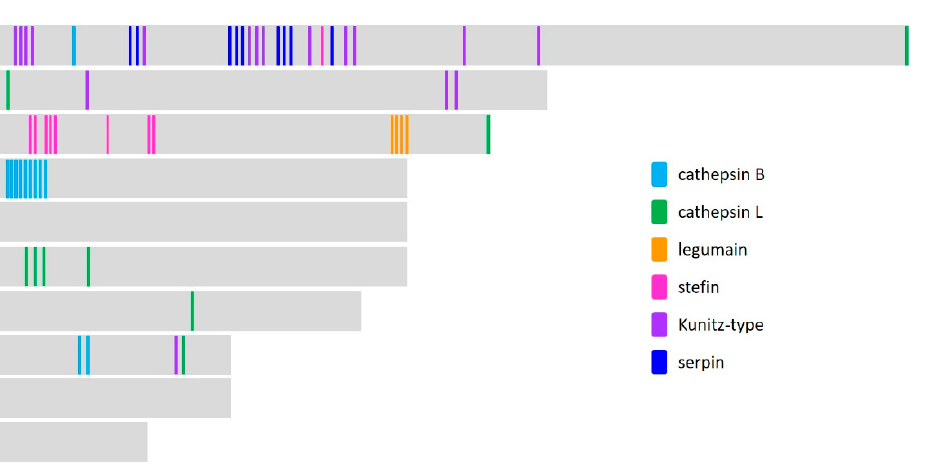
Figure 6. Graphical representation of the chromosomal location of the cathepsin peptidase, legumain and peptidase inhibitors genes within the F. gigantica genome. The schematic is not drawn to scale but displays the relative position of the genes within the ten chromosomes.